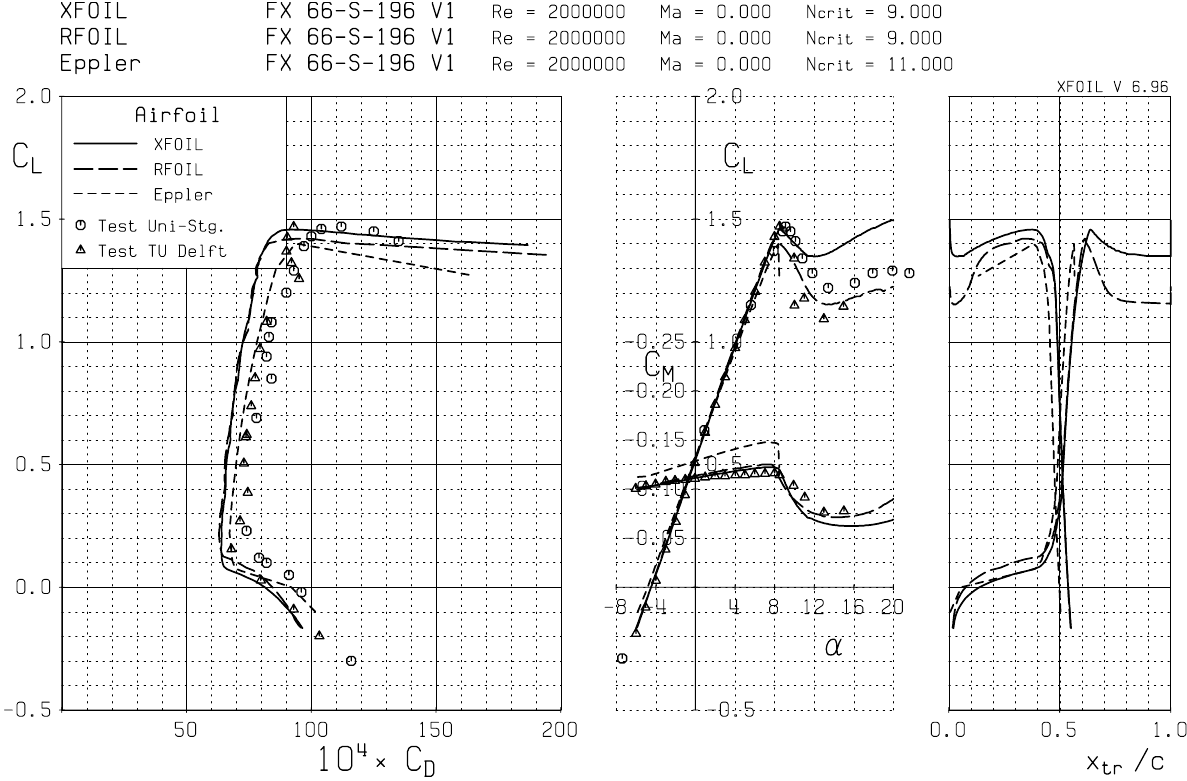
Fig 6. Comparison of calculated and measured data of FX 66-S-196VI airfoil at Re = 2·10